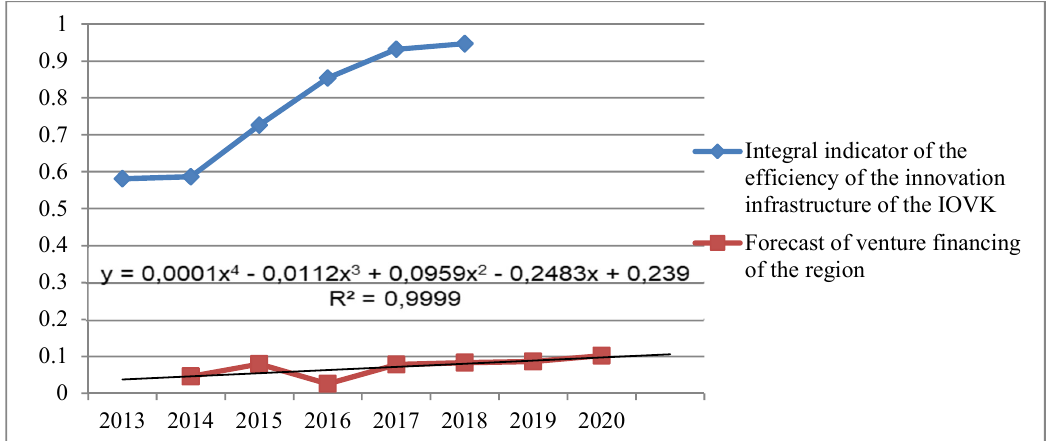
Fig. 3. Multiplicative effect of innovation infrastructure in the